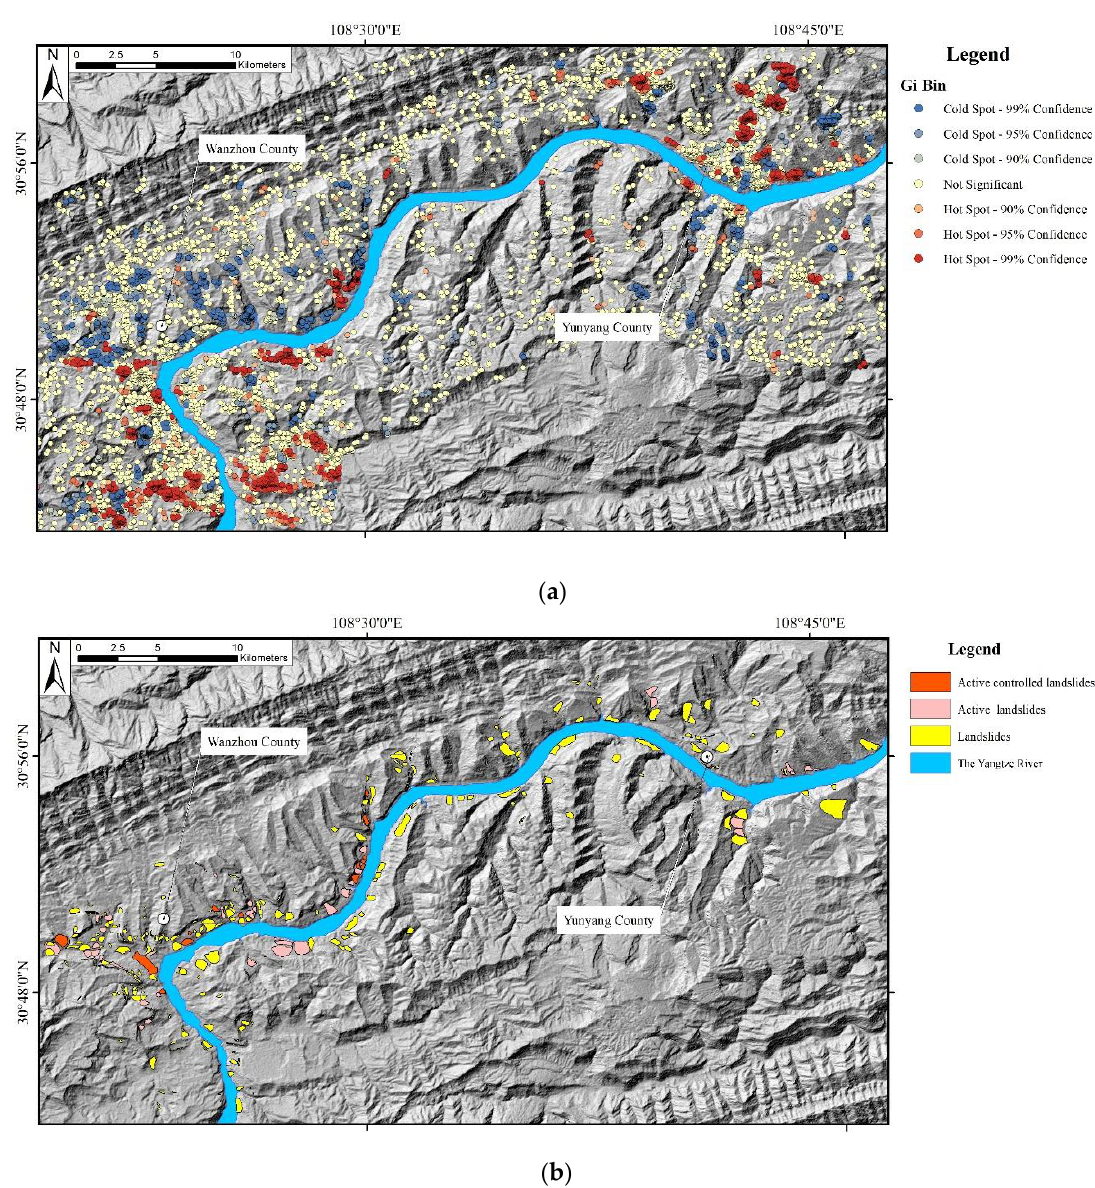
Figure 5. ( a ) Persistent Scatterer Interferometry (PSI) hotspot maps of the entire study area including the main district from Wanzhou to Yunyang county. Red hotspots and blue hotspots correspond to the clustering of PSs with high deformation rates. ( b ) Landslide polygons rendered with different colors according to the hotspot map. Orange: Active landslides with engineering remedial works. pink: Active landslide area without engineering remedial works. Yellow: Other inactive landslides. Four numbered landslides are representative landslides combining field investigation and ground monitoring data, which will be discussed in the following section.